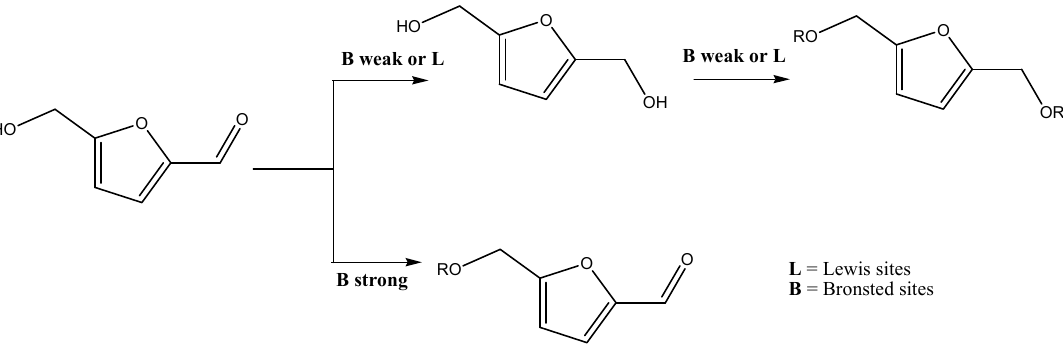
Scheme 9. Main products obtained by varying the acidity of the catalytic